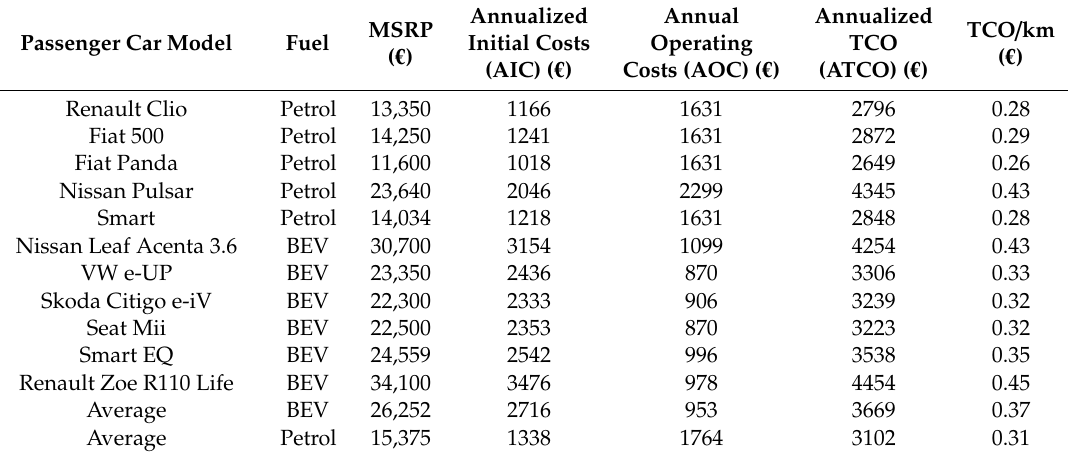
Table 4. Estimates for passenger cars: baseline scenario.